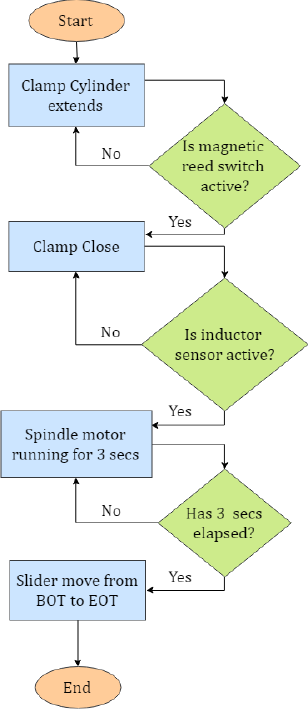
Figure 4. Flowchart illustrating the control sequence of the torquing